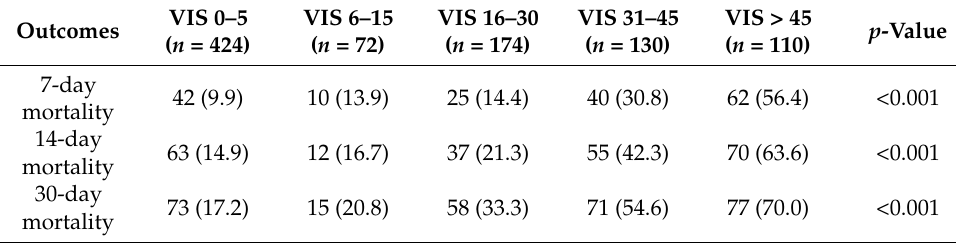
Table 3. Clinical outcomes (short-term mortality) according to each VIS